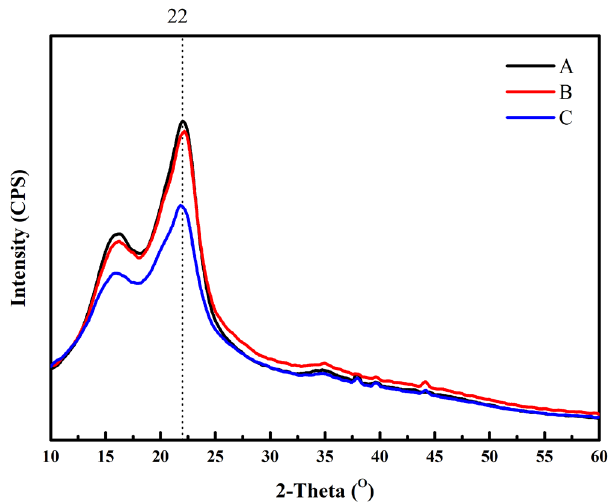
Figure 2. FTIR spectra of maleic acid adhesive, sorghum bagasse, and TTBSB-particleboard prepared at 200 °C for 20 min, and their scheme reaction.